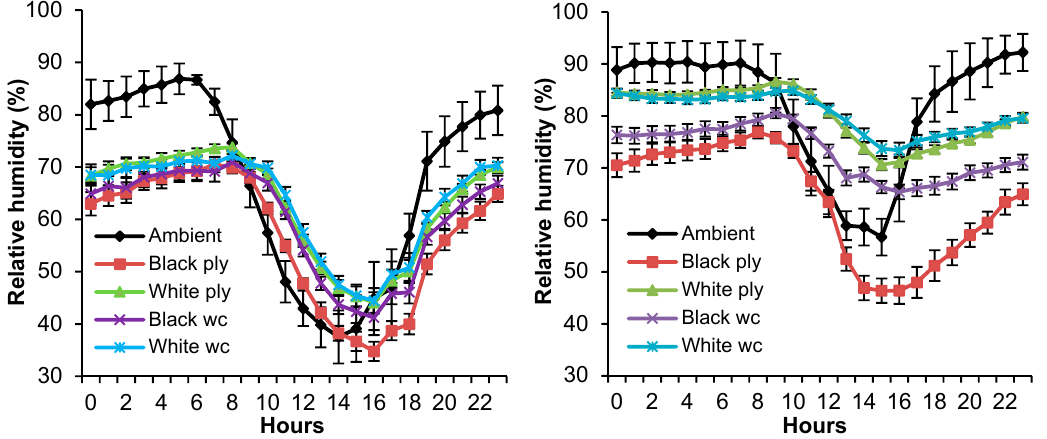
Figure 8. Mean front chamber RH in each box design and ambient RH. Left : 5-day summer hourly means ( ± SE) (n = 6 for each plywood box design; n = 4 for each wood-cement box design). Right : 5-day winter hourly means ( ± SE) (n = 4 for each box design). ply = plywood; wc = wood-cement. Table 6. Pairwise comparison of box designs in front chambers for ‘warmest day period’ RH over the 5-day period for summer and winter. ply = plywood; wc = wood-cement.